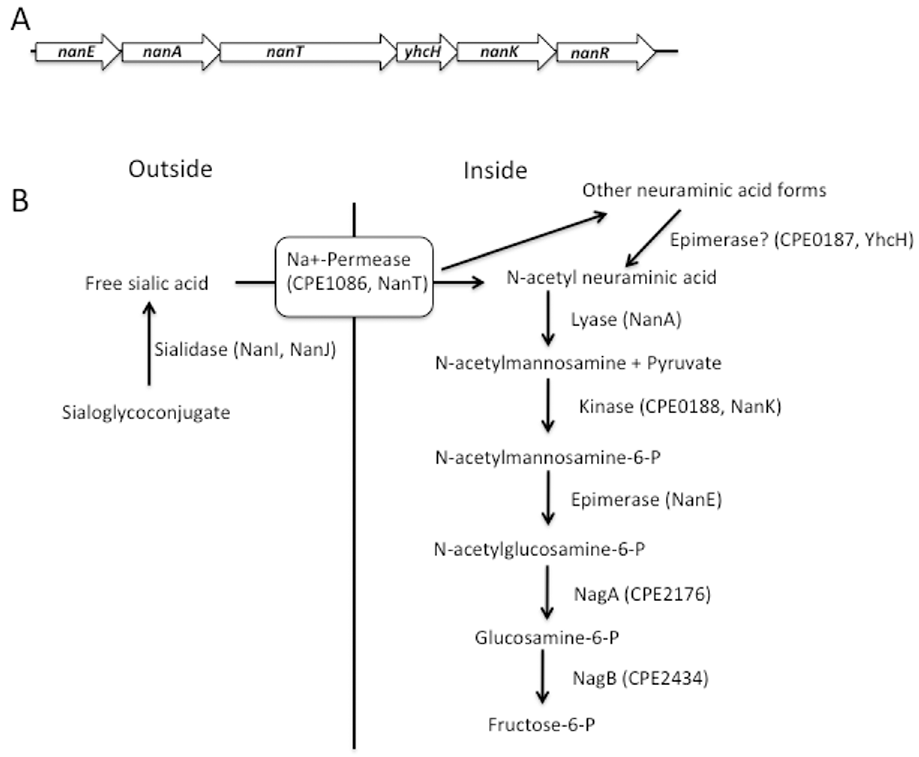
Fig 1. Genes encoding enzymes involved in sialic acid metabolism in C . perfringens . (A) . Structure of the putative nanEAT - yhcH - nanKR operon in strain 13. (B) . Proposed pathway of sialic acid metabolism in C . perfringens strain 13 in relation to the gene content in panel